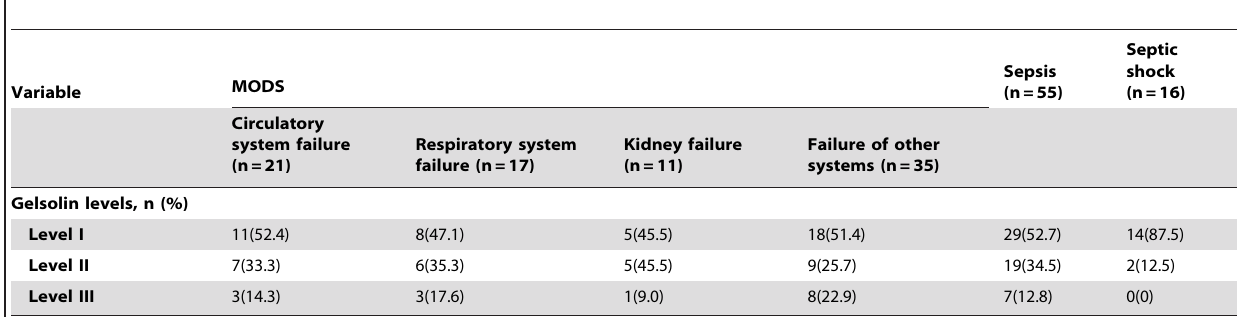
Table 3. The relationship between pGSN levels and the incidences of sepsis and MODS in burned patients.